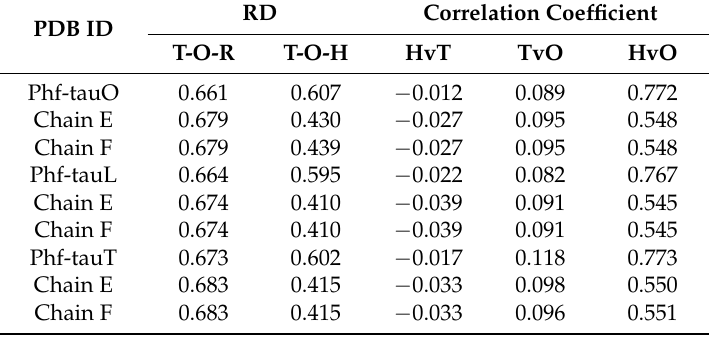
Table 3. Status of individual chains treated as components of their respective proto-fibrils. The table lists only values obtained for the proto-fibril (chains A, C, E, G and I) (Differences with regard to the other proto-fibril are